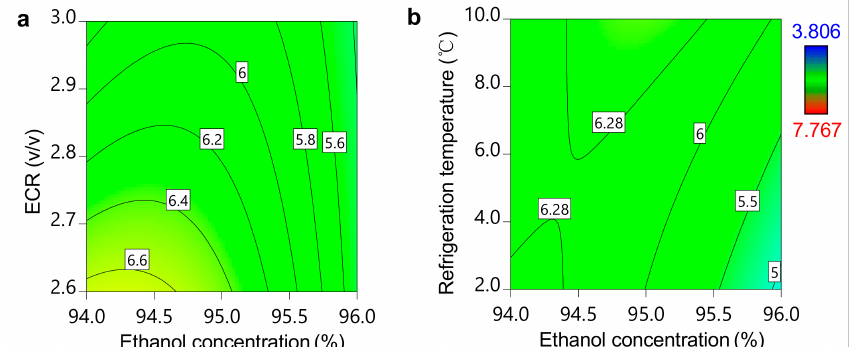
Figure 5. Contour plot of the extracted amount of HSYA. ( a ) Density of concentrated extract was 1.23 g/cm 3 , stirring time after ethanol addition was 90 min, refrigeration temperature was 6 ◦ C. ( b ) Density of concentrated extract was 1.23 g/cm 3 , ECR was 2.8 v / v , stirring time after ethanol addition was 90 min.